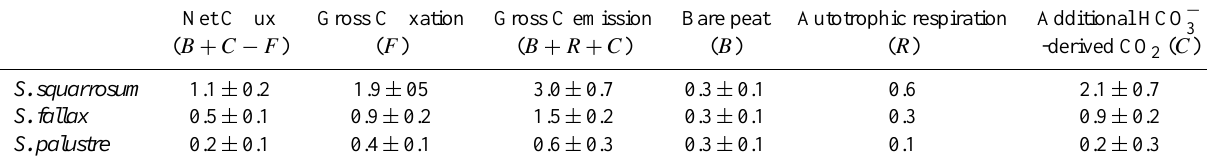
Table 4. Origin and rates of C fluxes (in gCm − 2 d − 1 ) of peat covered with different species of Sphagnum . Net C fluxes, gross C fixation rates and gross C emissions are based on closed chamber measurements carried out under light and dark conditions. Other fluxes are calculated using Eq. (1), with the fraction of autotrophic respiration based on the maximum value found for Sphagnum respiration in the literature (31%, Laine et al.,